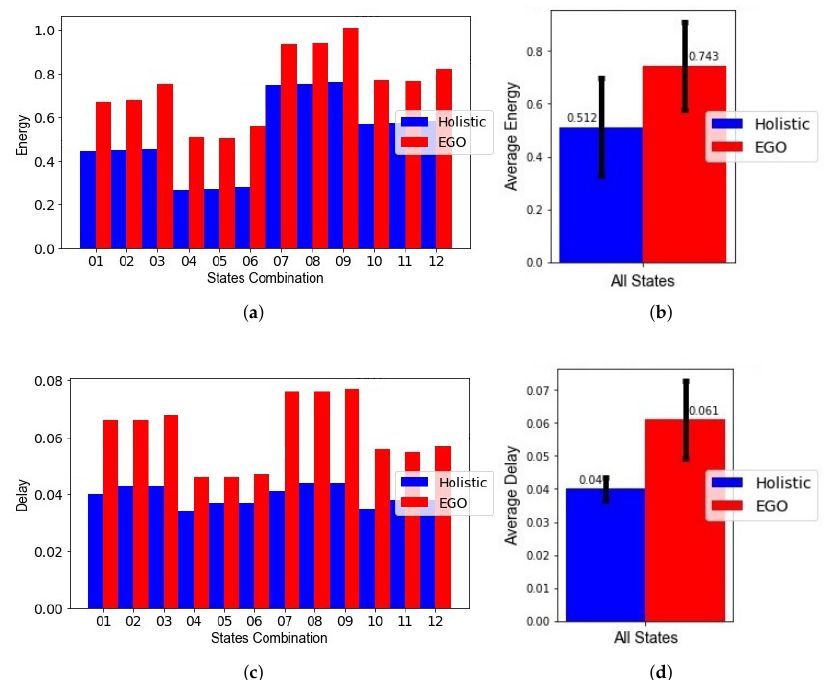
Figure 14. A comparison between the holistic approach using the new behavioral model and EGO with its own behavior model for ( a ) normalized energy and ( c ) normalized delay for each state’s combination scenario; ( b ) average normalized energy and ( d ) average normalized delay for all states’ combination scenarios.